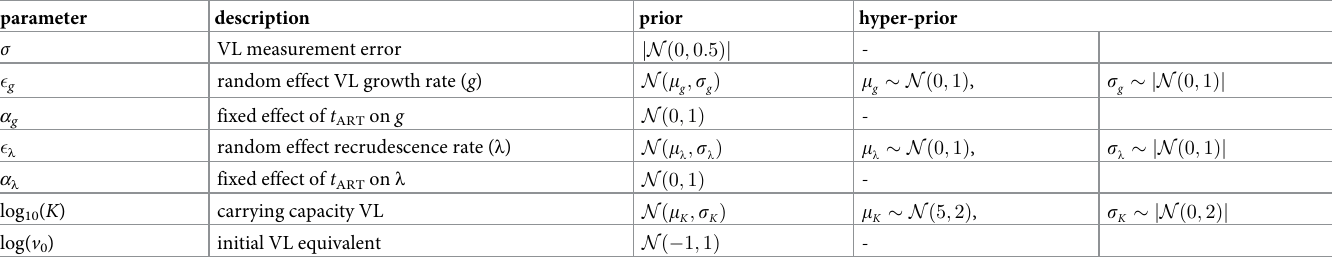
Table 2. Prior distributions of the Bayesian mixed-effects